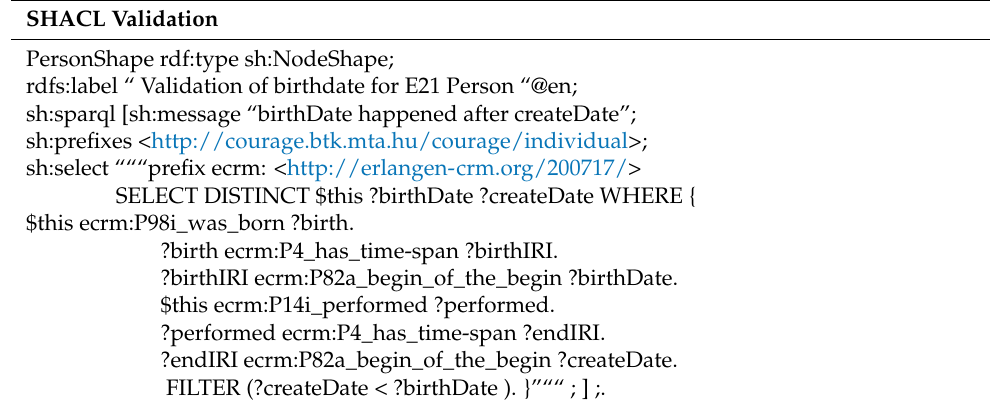
Table 5. Semantic validation using SHACL shape. SHACL